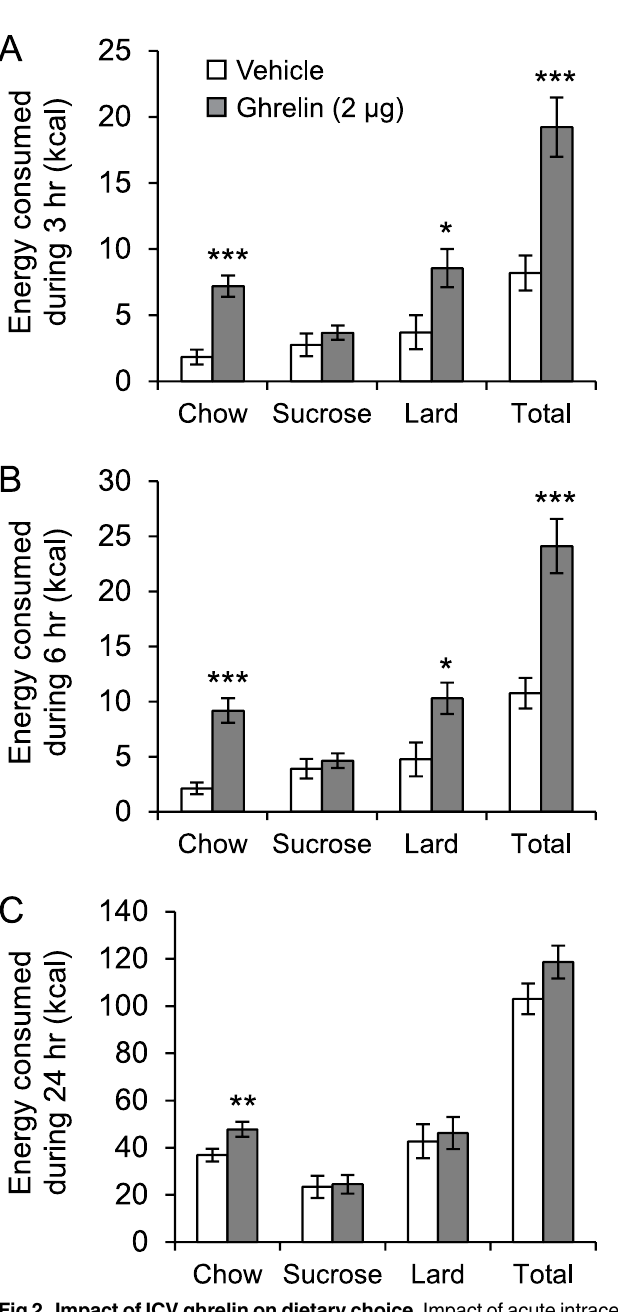
Fig 2. Impact of ICV ghrelin on dietary choice. Impact of acute intracerebroventricular (ICV) injection of ghrelin on total energy intake and dietary choice during (A) 3 hr, (B) 6 hr and (C) 24 hr, in rats (n = 18) that had been ad libitum fed a choice diet comprising normal chow, 1 g sucrose pellets and lard (saturated animal fat) over the previous 14 days. All rats received ghrelin and vehicle solution in a cross over design with one day washout between injections. * P < 0.05, ** P < 0.01, *** P < 0.001. 3 hr and 6 hr JMV2959 decreased chow intake by 25% (P < 0.01) and by 22% (P < 0.01) respec-